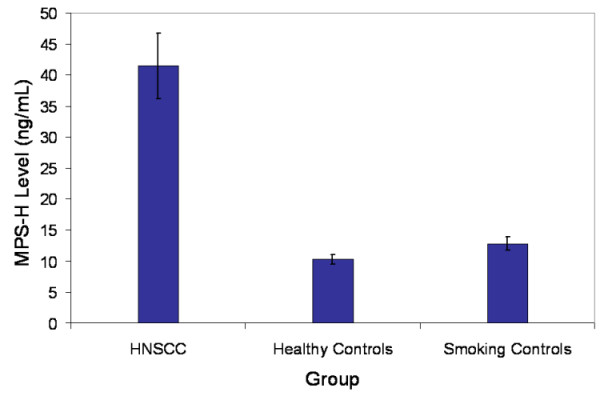
Mean serum MPS-H level for patients with SCC (n = 125, all stages and sites within the head and neck), healthy control group (n = 51) and actively smoking volunteers who were screened for HNSCC (N = 64). Mean of SCC group is 41.5 ng/mL, mean of healthy control group is 10.2 ng/mL, and mean of screening controls is 12.8 ng/mL (p < 0.0001). Error bars denote 1 standard deviation.